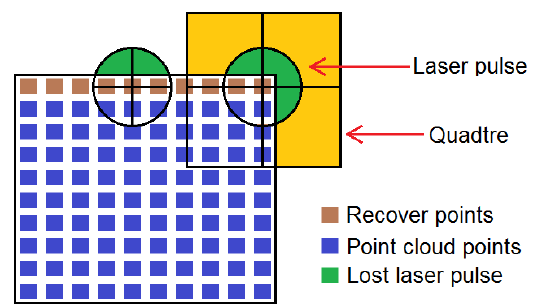
Figure 5: The green area is the lost part of the laser pulse that was estimated correctly by the quadtree, but the synthetic intensity value generated was equal to all points.